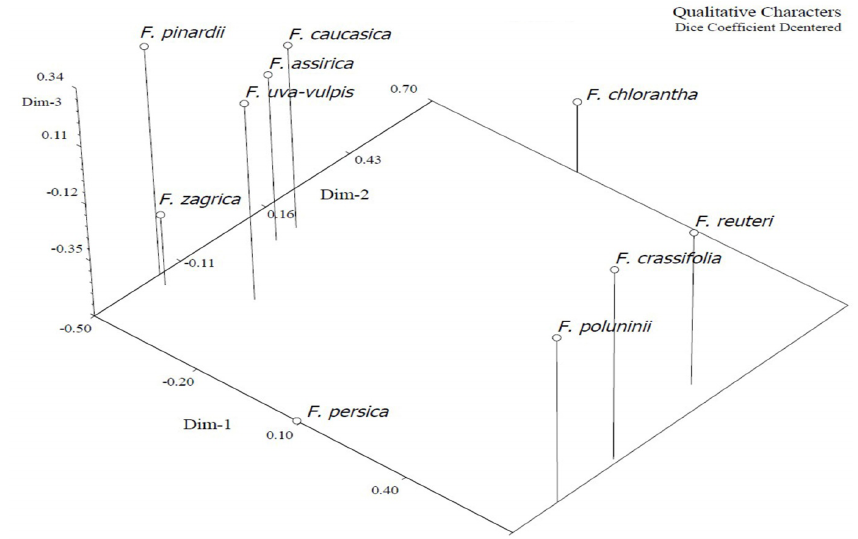
Fig. 3. Plot of PCO analysis of qualitative morphological characters. Resultant groups similar to Fig. 2 but F. chlorantha distantly grouped with members of sect. Olostyleae .